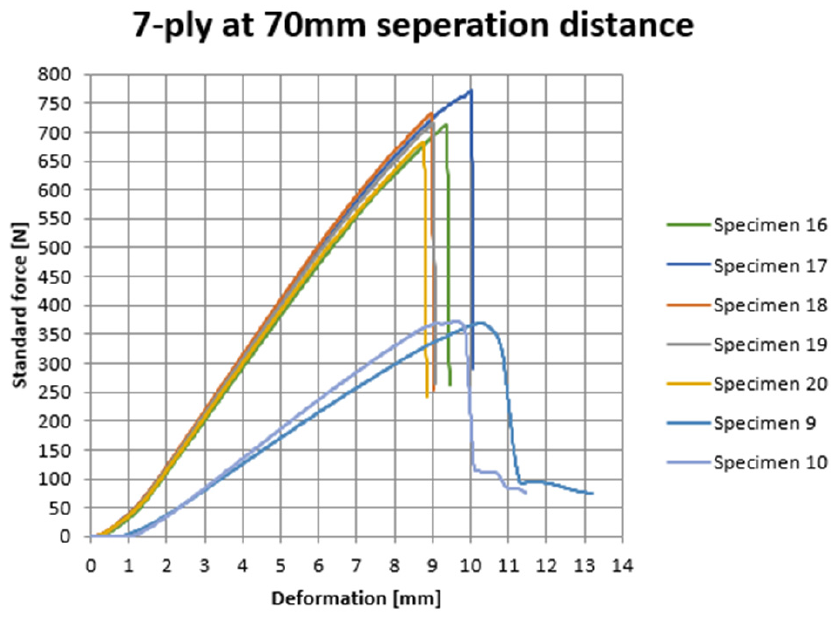
Figure 3. Deformation profile for a 7-ply samples. Table 1. CF specimen’s characteristics, production methods and calculated values of stiffness value (k).